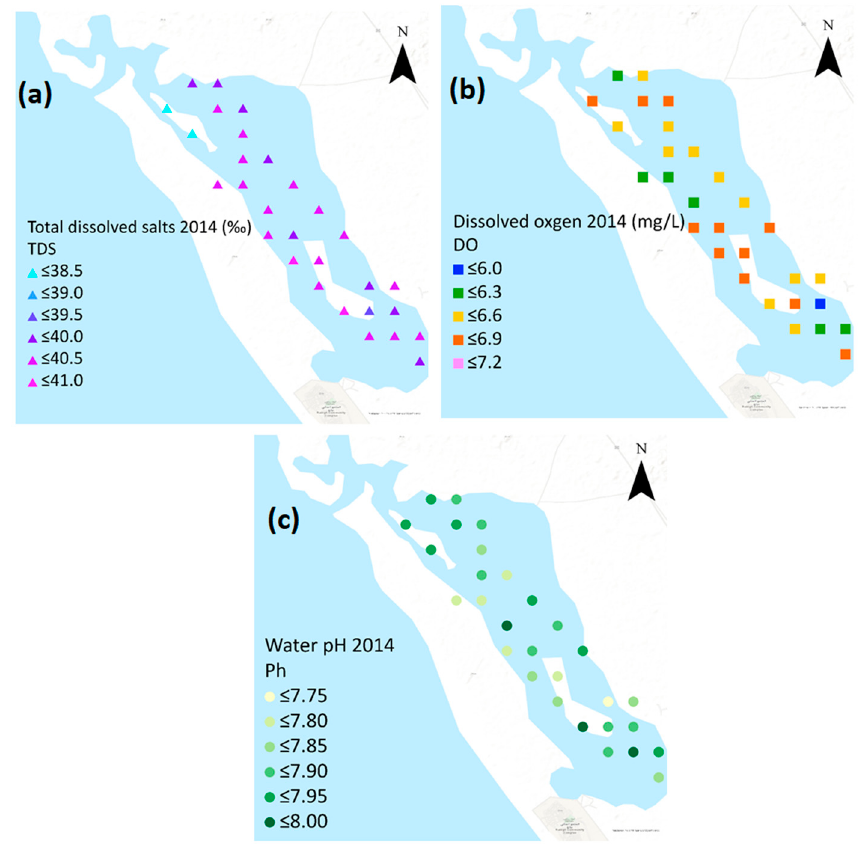
Figure 10. Surface water parameters ( a ) salinity or dissolved salts, ( b ) dissolved oxygen and ( c ) pH. The sampling and estimation was done in 2014 [55].